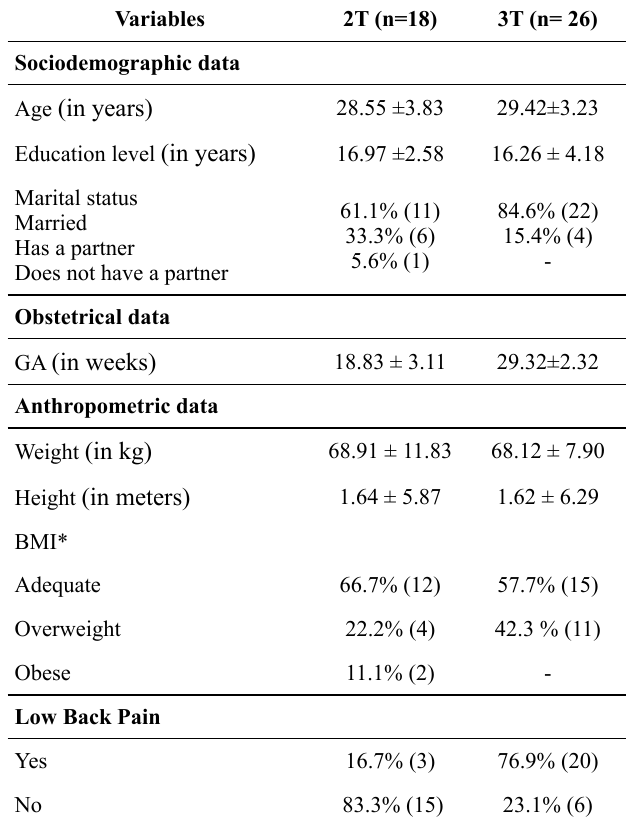
Table 1. Sociodemographic, obstetrical and anthropometric charac- teristics of pregnant women participating in the study at the